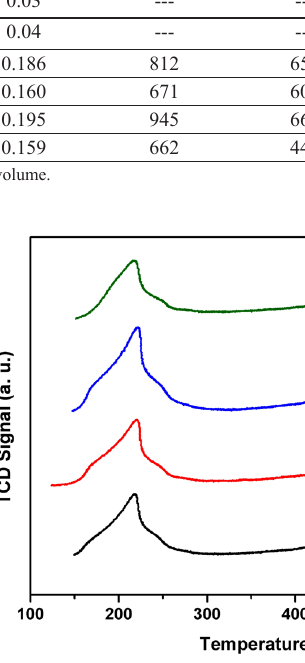
-TPD profiles of the SSZ-13 Figure 5. NH 3